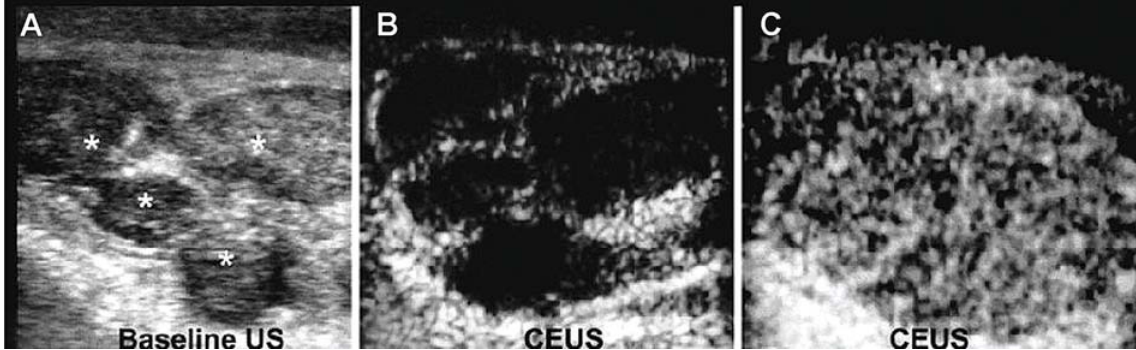
Figure 7 – Extratesticular hematoma. Patient with a painful lump at the upper part of the right hemiscrotum and history of closed scrotal injury 25 days ago. A) On baseline ultrasound US, a few ovoid hypoechoic structures ( * ) are demonstrated above the testis. B) On contrast-enhanced ultrasonography (CEUS) they lack enhancement. C) Normal enhancement of the ipsilateral testis for